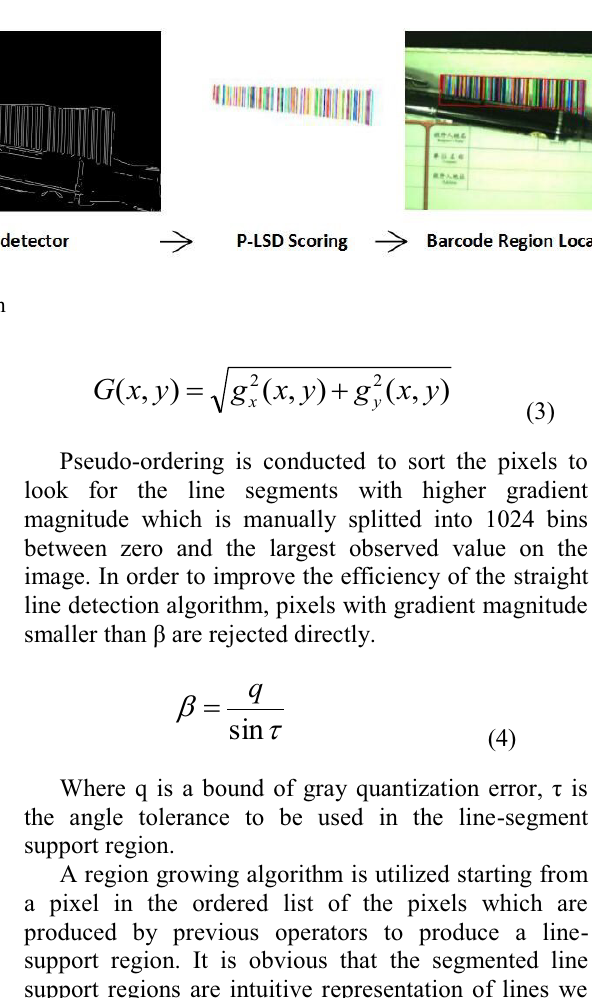
Figure2. The core concept of Line Segment Detector (LSD)